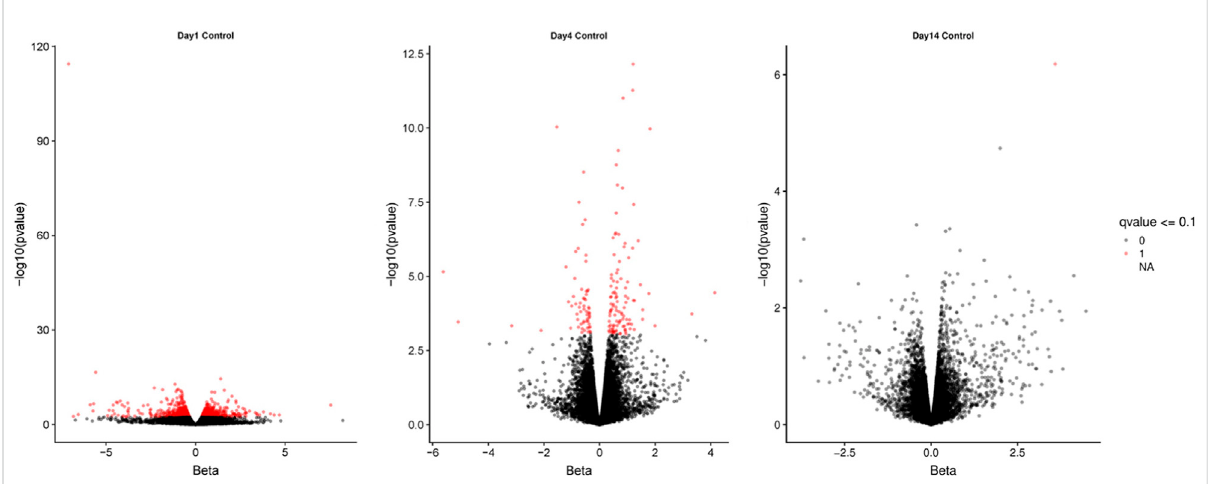
FIGURE 1 Volcanoplotsofdifferentiallyexpressedtranscriptsbetweenweanedandunweanedpigsat1,4,and14dayspostweaning.Redpointsindicates genes signi fi cant at Qval ≤